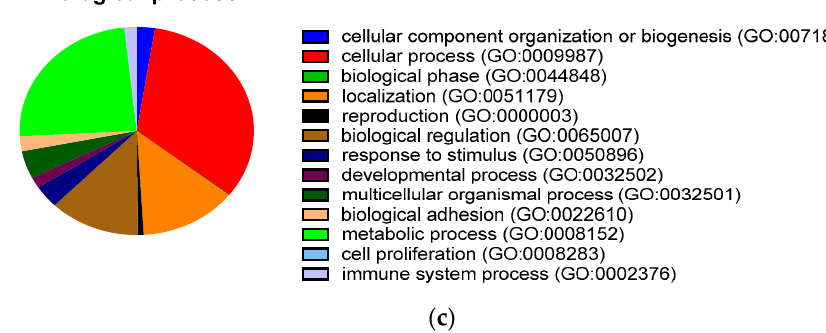
Figure 2. Proteomic analysis of pancreatic cancer-derived EVs. ( a ) The cellular component of proteins in TBO368-derived EVs and L3.6pl-derived EVs. ( b ) The molecular function of identified proteins in pancreatic cancer-derived EVs. ( c ) The biological process of identified proteins in pancreatic cancer-derived EVs.